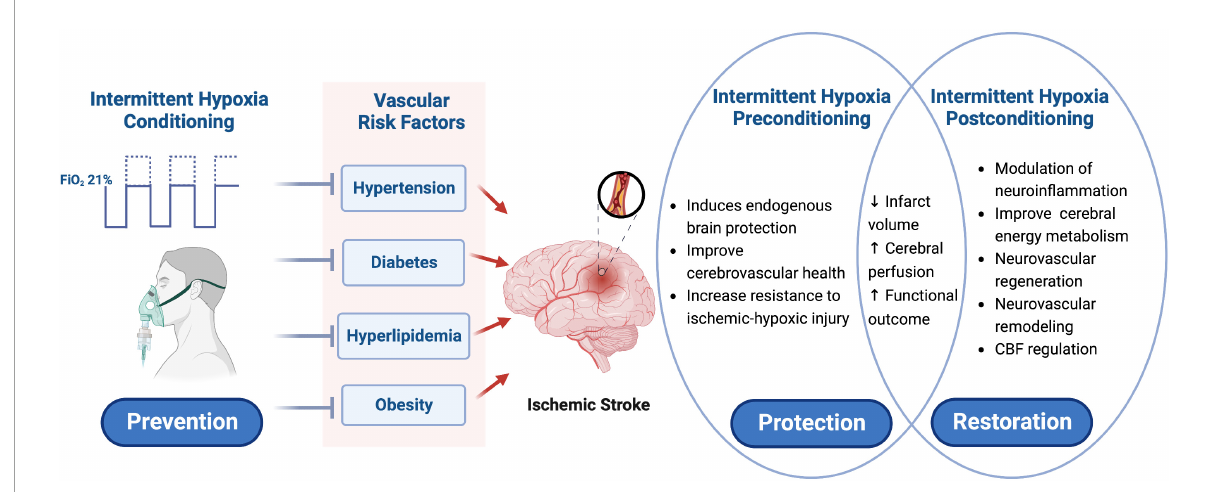
FIGURE2 Schematic presentation of intermittent hypoxia conditioning as a potential prevention and treatment strategy for ischemic stroke. IH conditioning can improve the conditions considered as risk factors for cerebrovascular diseases, such as high blood pressure, glucose, and lipid content, and high body weight, which is a potential treatment strategy to prevent IS and reduce its incidence and recurrence rate. IH preconditioning induces endogenous cerebral protective mechanisms, improves cerebrovascular health, and enhances the resistance of the brain to ischemic-hypoxic injury. IH postconditioning can modulate neuroinflammation, improve brain energy metabolism, promote neurovascular regeneration and remodeling, and regulate cerebral blood flow. Applying IH conditioning at different stages of IS may ultimately reduce infarct volume, improve cerebral perfusion, and promote neurological recovery. IH, intermittent hypoxia; IS, ischemic stroke. Created with